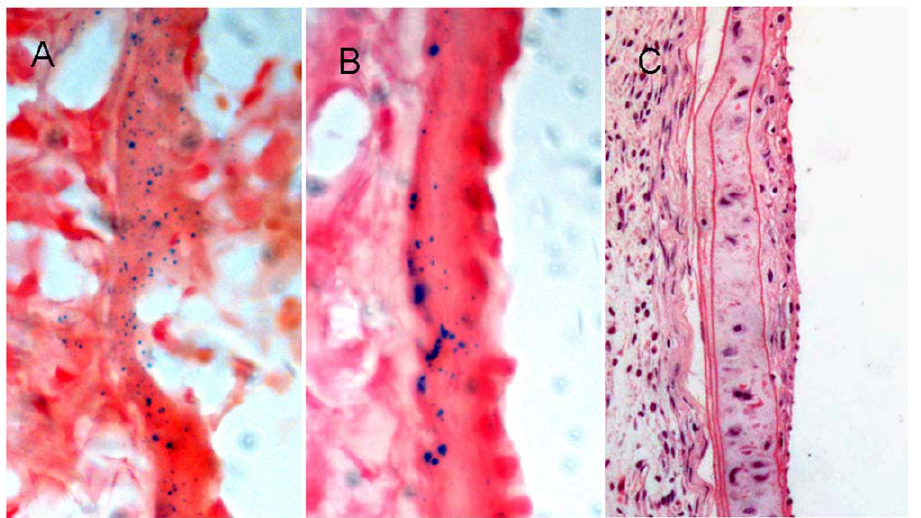
Figure 7. Histopathological analysis. Prussian blue staining showed blue particles of Fe 2 O 3 -PLL labeled EPCs distributing in subendothelium (Figure 7A, 7B indicated 5, 10 days after endothelium injury respectively). Figure 7C showed crescentic neointima of injured artery in 2 animals of non- EPC transfusion group. (Magnification 6 200).